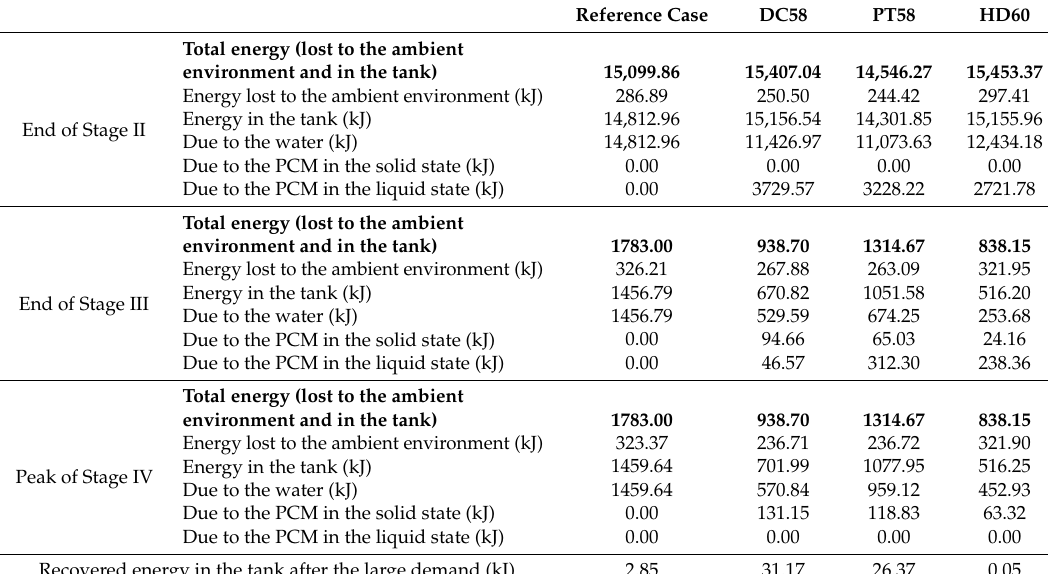
Table 11. Energetic analysis